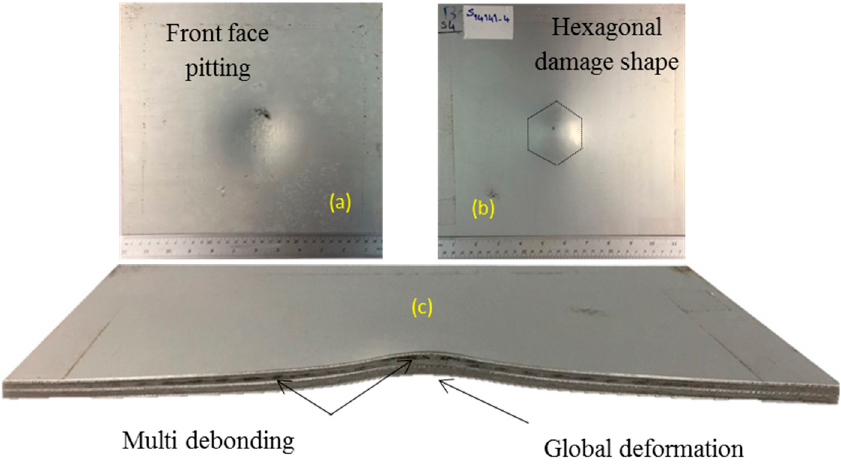
Figure 10. Sample code S14141-4 subjected to impulse 18.8 N.s ( a ) front face, ( b ) back face, ( c ) cross- ( c ) section.